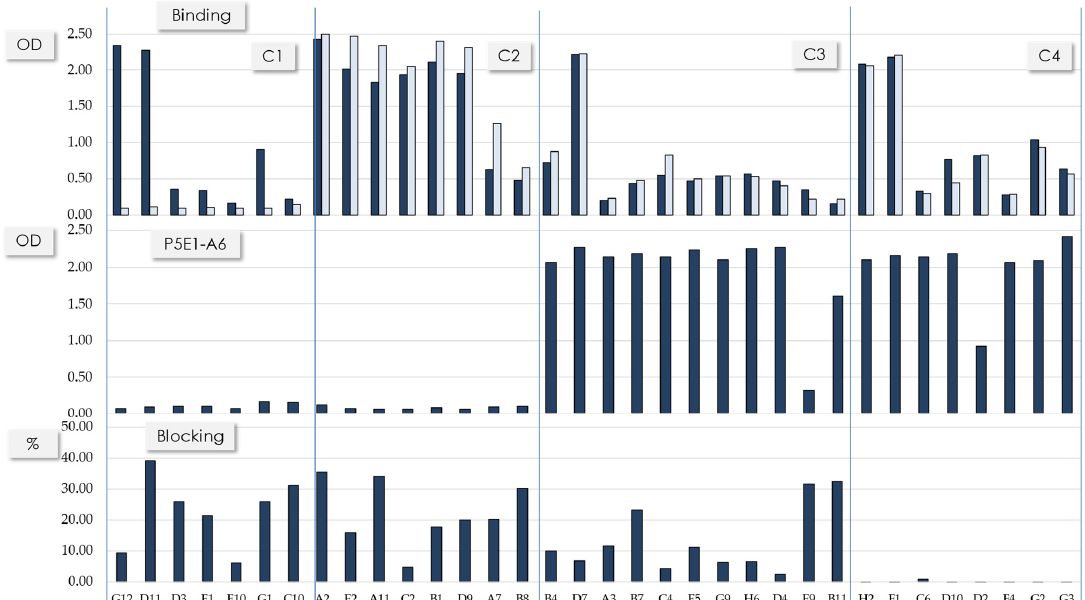
Figure 1. Functional profile of the unique scFvs. Binding to RBD-WT and RBD-DT (top), competition with P5E1-A6 (middle) and RBD-WT:hACE2 blocking interaction (bottom). A scFv was considered positive in the binding assay if it has at lead 2× the negative control OD value. Vertical lines divide the clones into four functional clusters (C1–4).